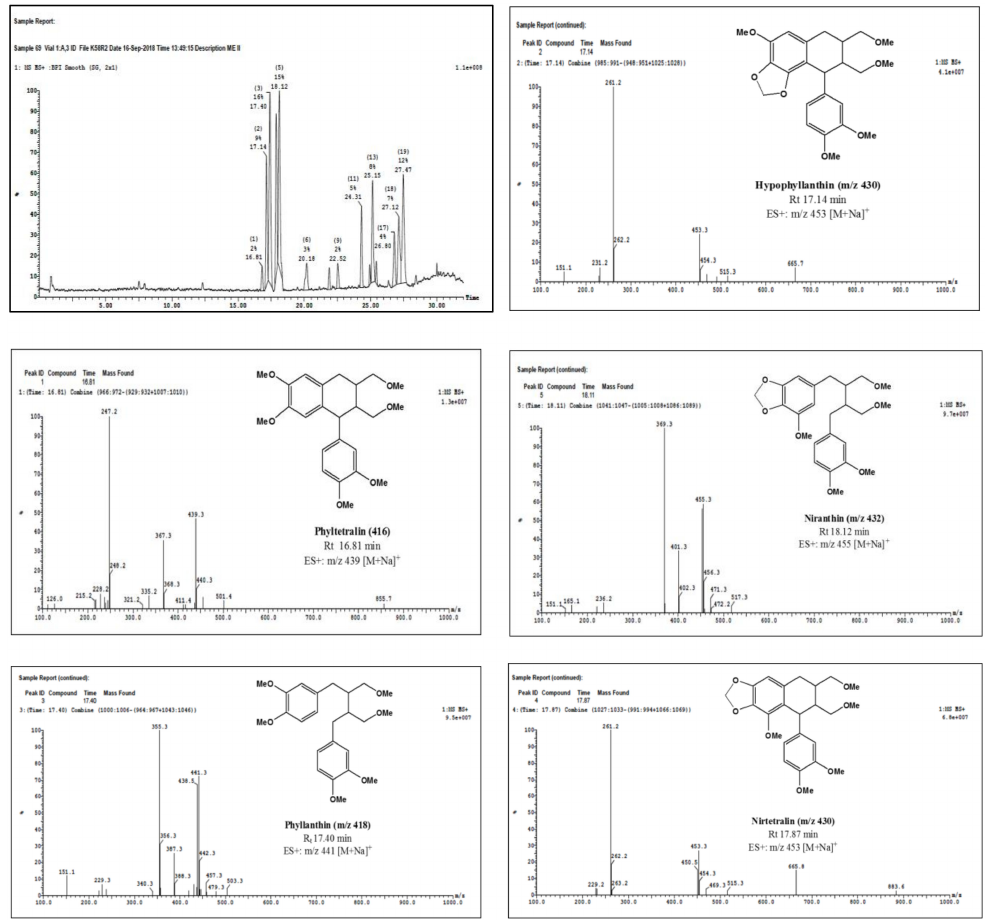
Figure 1. ESI-MS spectra of major lignans identified in the extract of the aerial parts of P. niruri